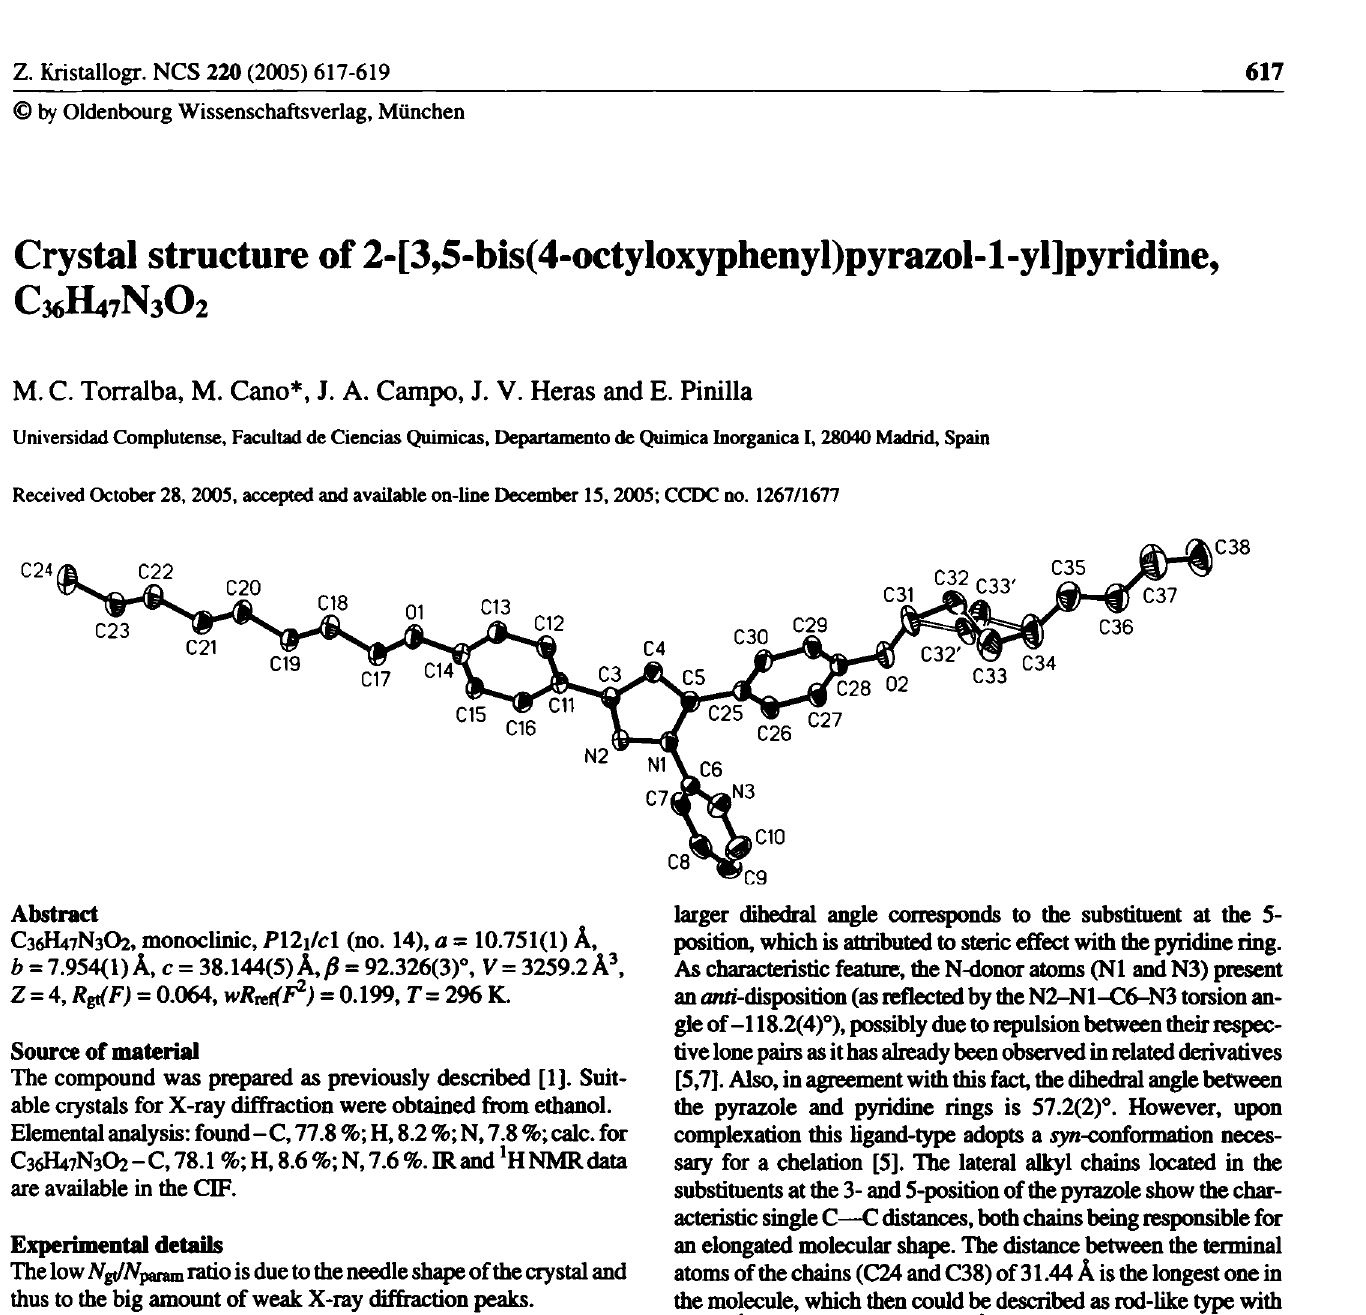
Table 1. Data collection and handling. Crystal: